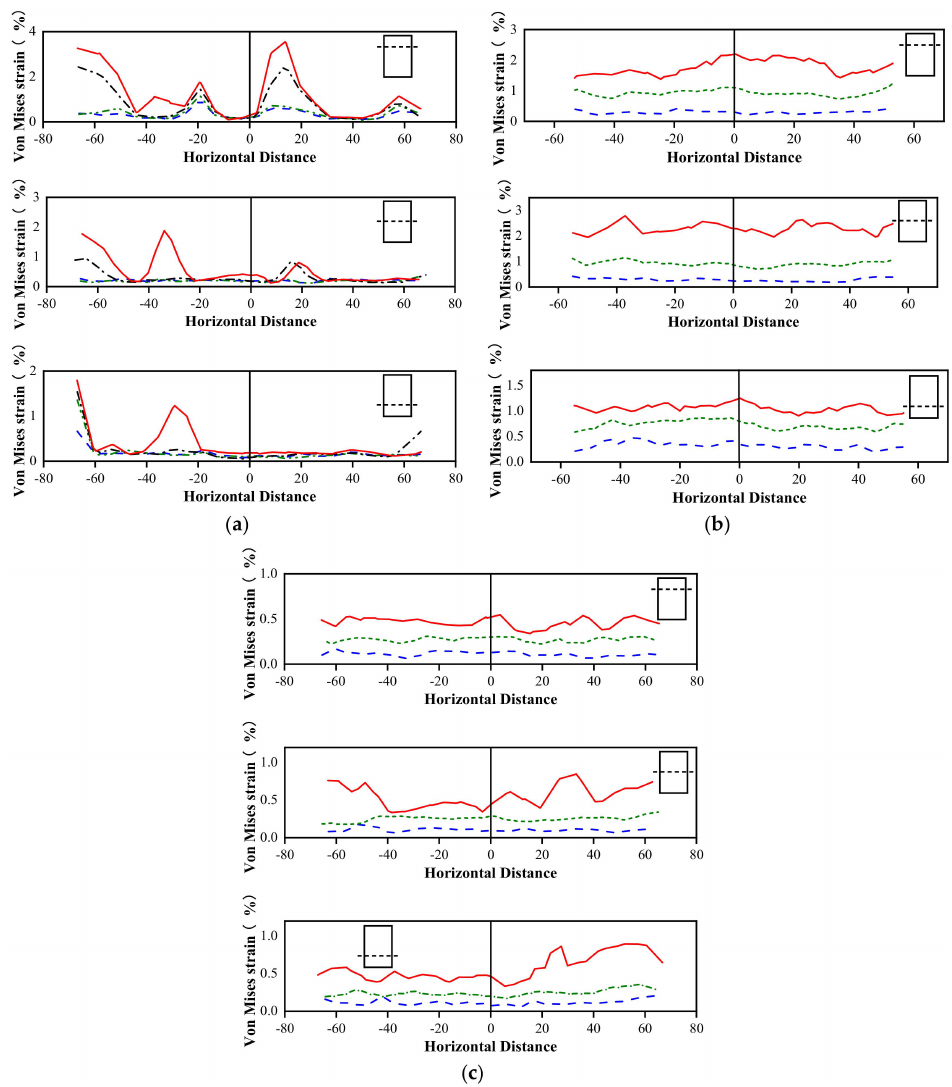
Figure 13. The lateral evolution of the Von Mises strain for the unconfined and confined specimens: ( a ) C; ( b ) E3; ( c )